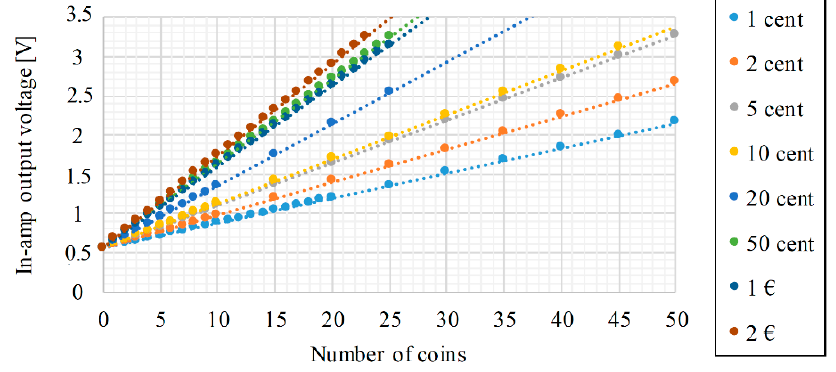
Figure 3. Graphical representation of the in-amp output voltage as a function of weight.